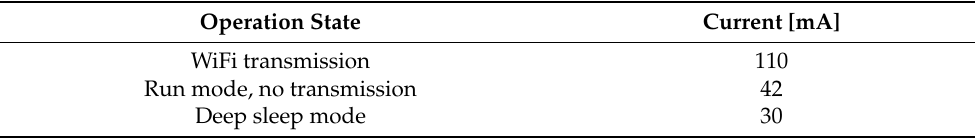
Table 5. Summary of energy consumption for smart IEQ sensor node.